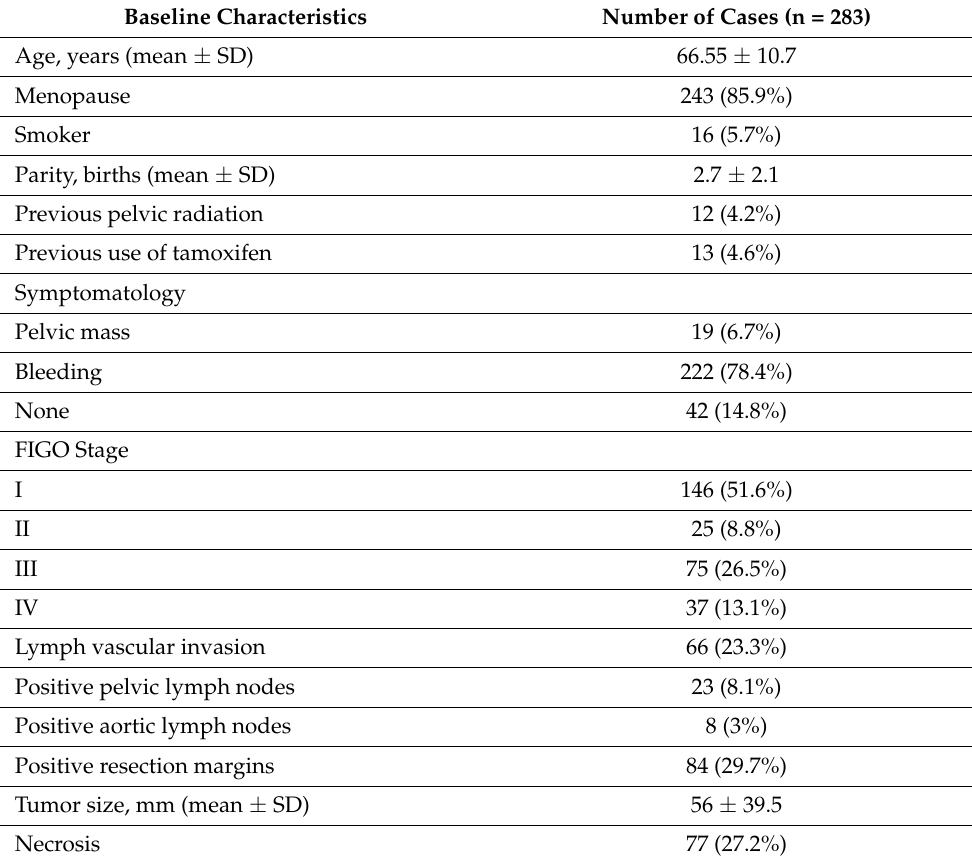
Table 1. Baseline characteristics and treatment modalities of patients with